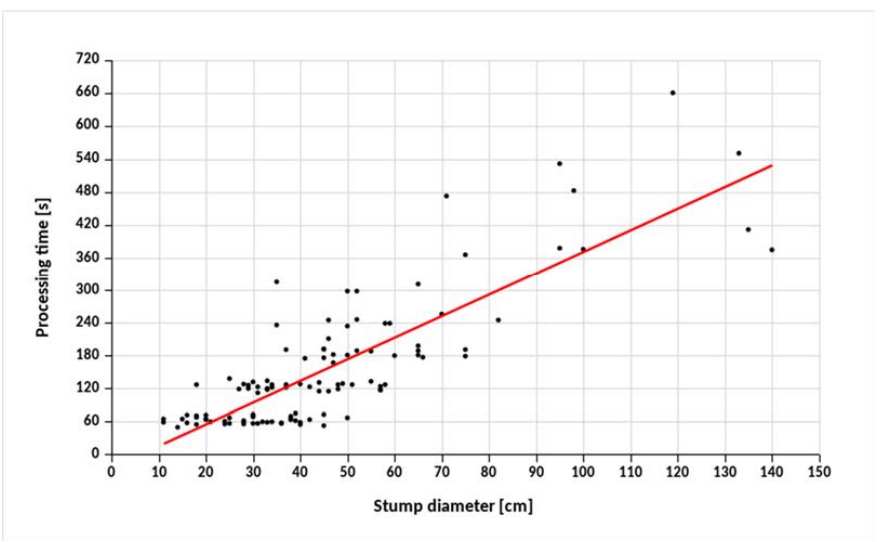
Figure 5. Statistical evaluation of time for processing one stump on the site of LHC Strážnice, district of Ratíškovice. of Rat í